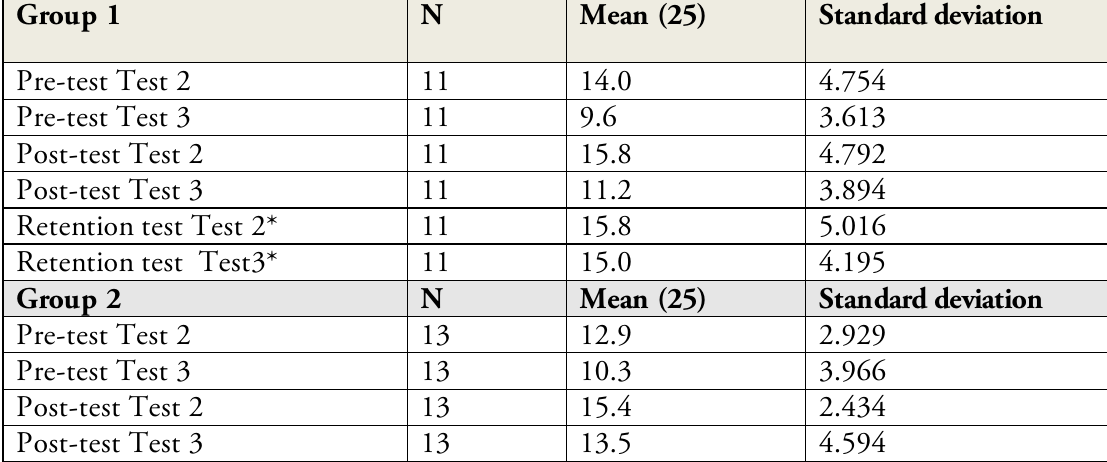
Table 1: Pre- and post-test results of participants * Retention test only applicable to Group